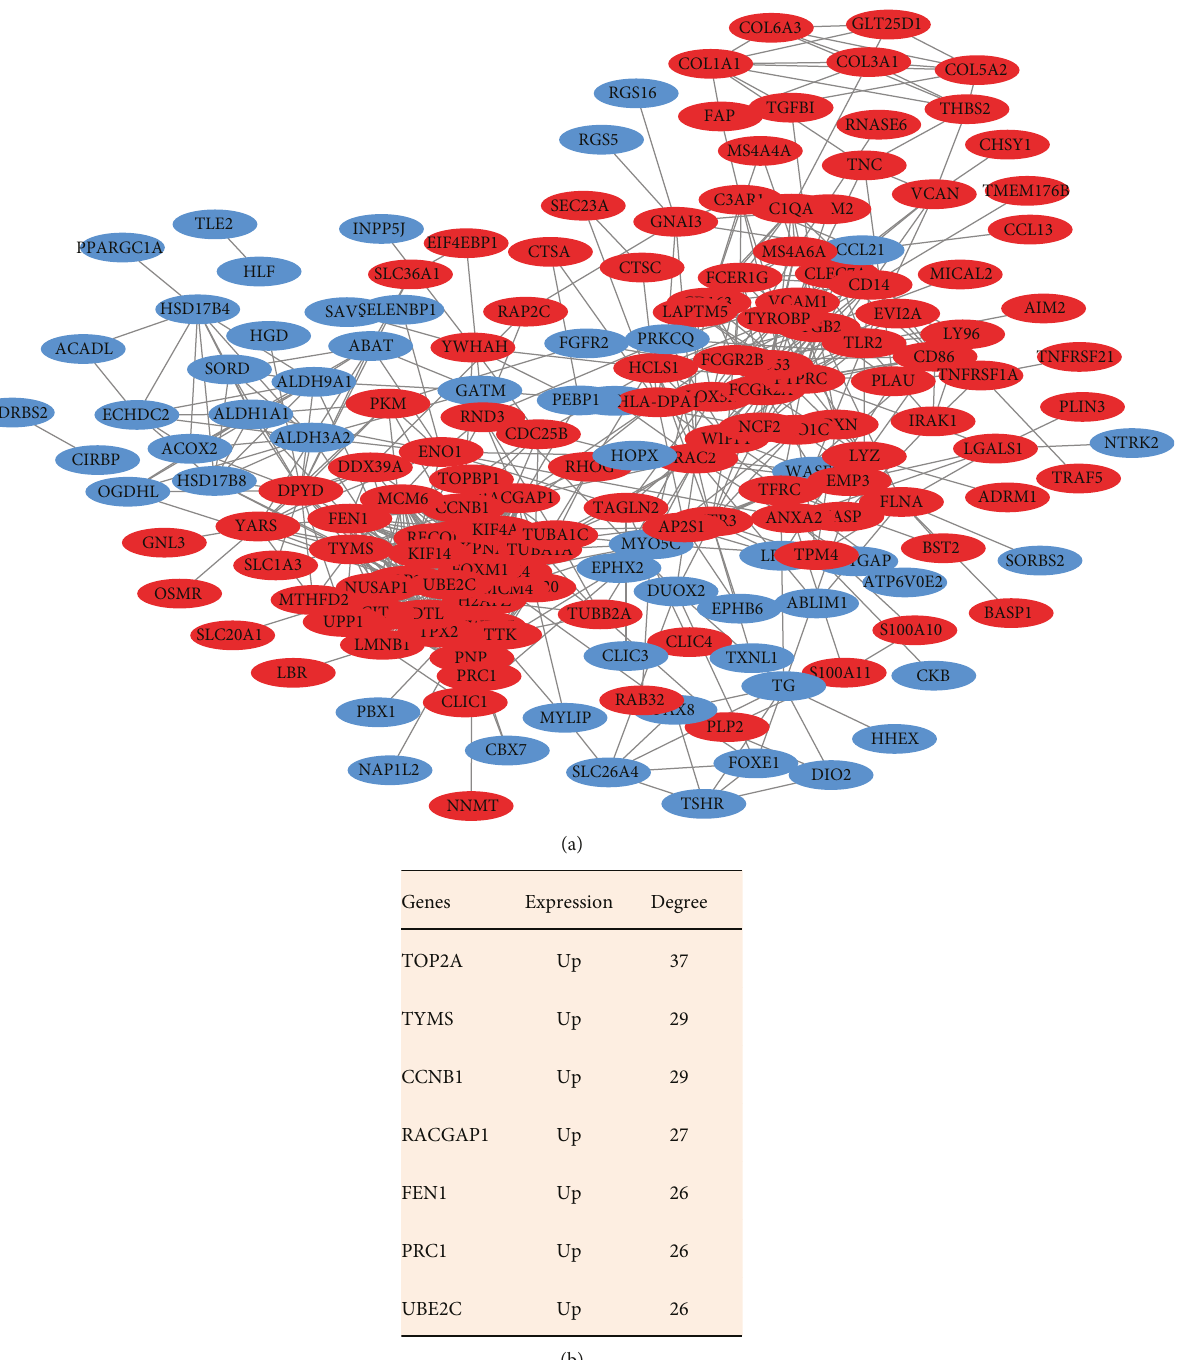
Figure 3: Protein-protein interaction (PPI) network of di ff erentially expressed genes (DEGs) ((a) PPI network; (b) hub